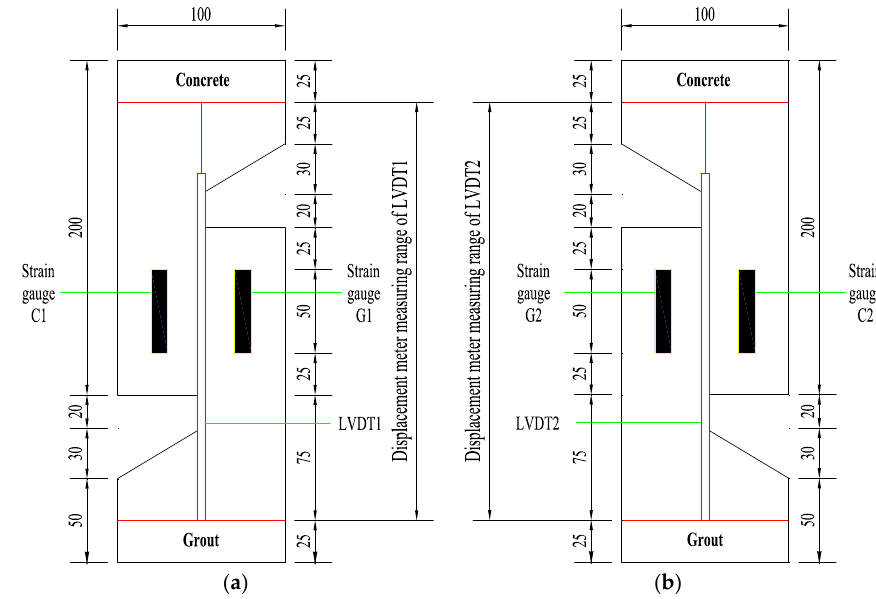
Figure 3. Layout of LVDTs and strain gauges: ( a ) Bond front view; ( b ) Bond back view.